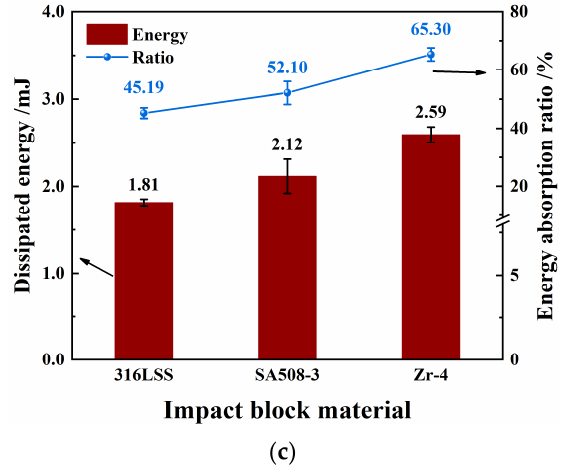
Figure 9. Dynamic response of impact velocity and energy with different impact block materials, N = 5 × 10 5 . ( a ) Impact velocity response vs. time; ( b ) impact energy response vs. time; ( c ) absorbed energy evolution. The dotted lines in ( a , b ) represent the initial impact velocity of 100 mm/s and the initial impact energy of 4.0 mJ for different impact block materials.